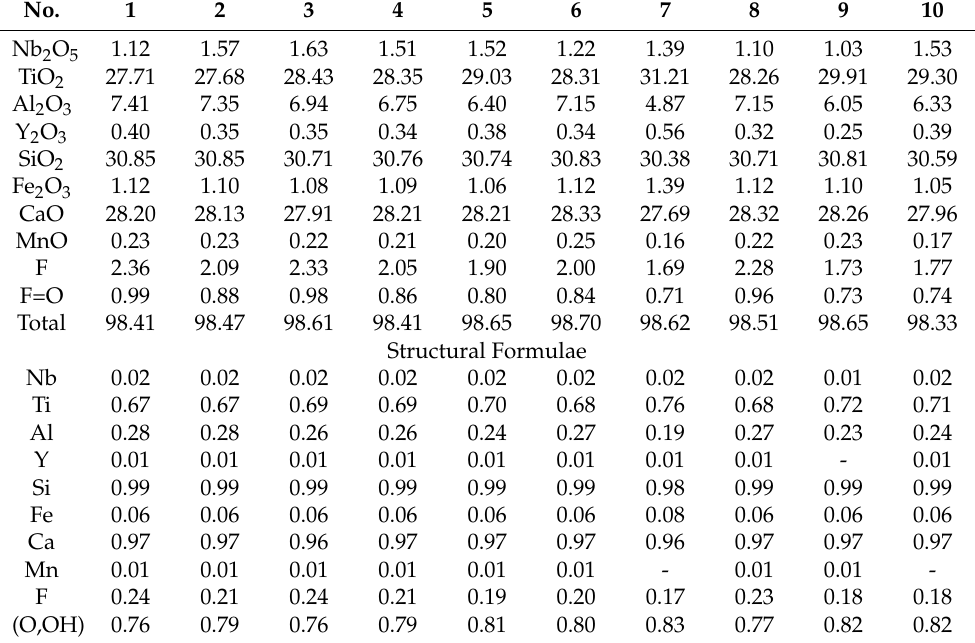
Table 3. Major elements of representative titanite of the Shuangshan nepheline syenite (wt.%).